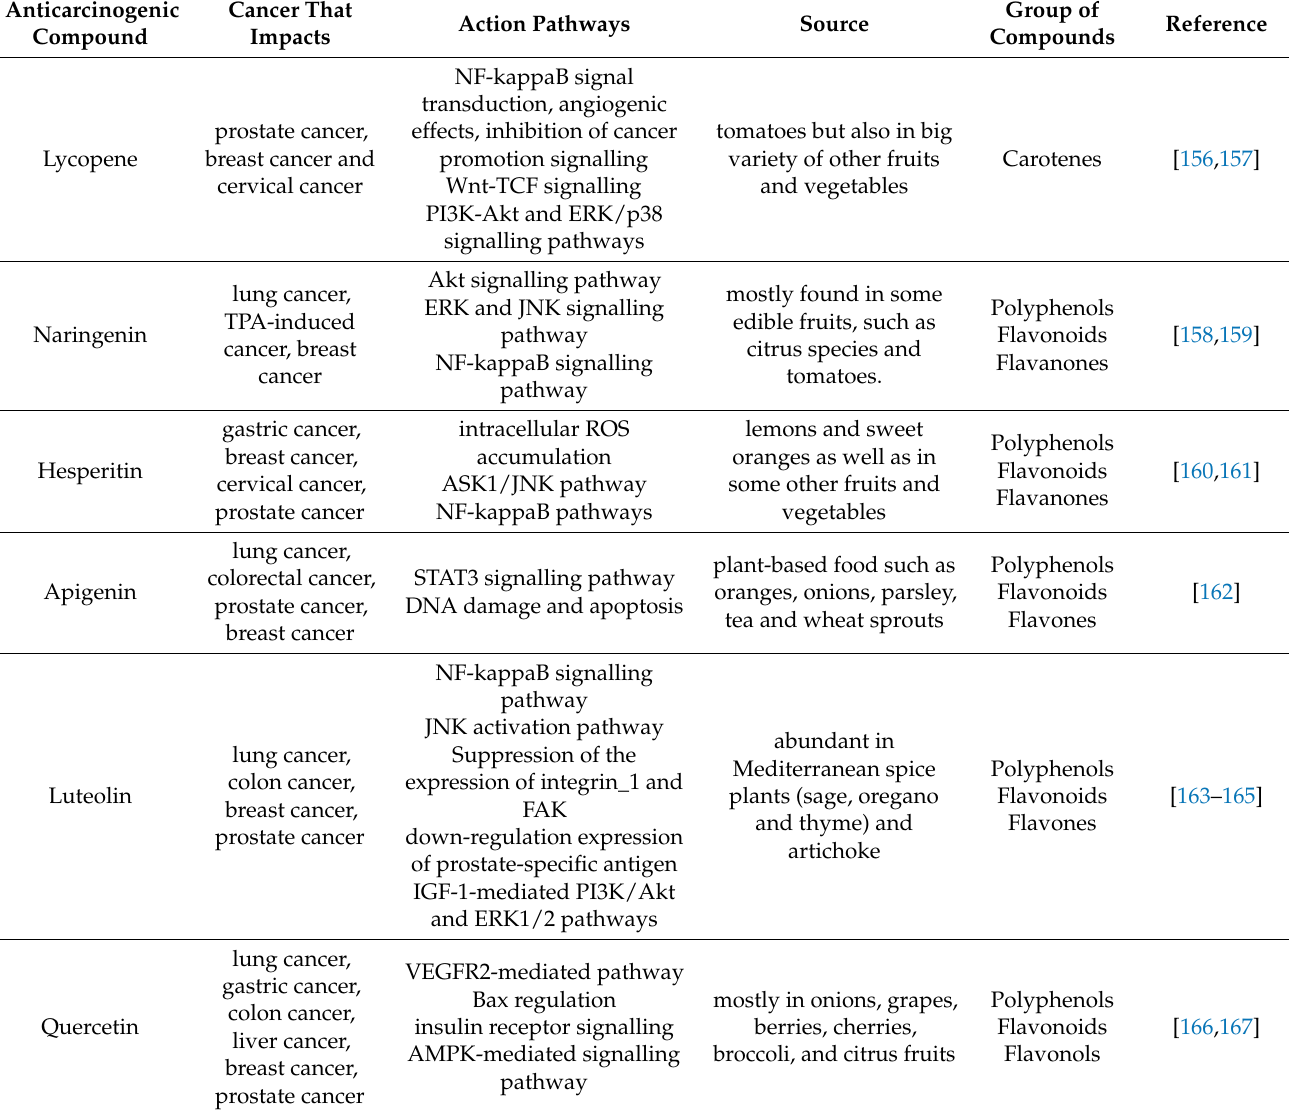
Table 1. Summarized list of bioactive compounds with antitumour properties along with their origin, target cancer type and signalling